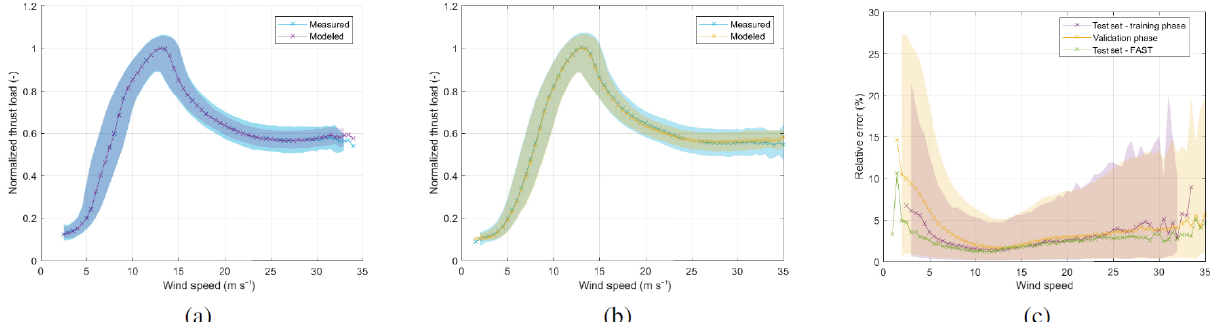
Figure 6. Modeled and measured thrust loads for the training data (training, validation and test set combined, being 2 weeks worth of data) (a) and the long-term validation data (1 year worth of data) (b) . The relative error (c) for the test dataset during the training phase and the dataset of 1 year during the validation phase is shown as well. The median values for relative errors obtained with the test set of FAST simulations are copied.